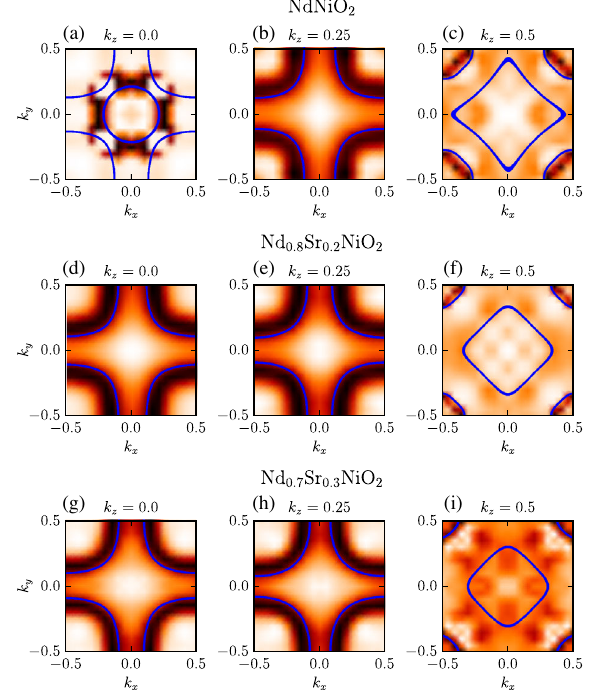
FIG. 4. Doping evolution of the Fermi surface. The blue lines show the LDA Fermi surfaces, while the intensity plots for the occupied states illustrate the “ Fermi surfaces ” of the interacting systems, calculated as the total spectral function at ω ¼ 0 . Here, the intensity scale is relative to the maximum value of this function. Analogous orbital-resolved plots with a fixed intensity scale can be found in the SM